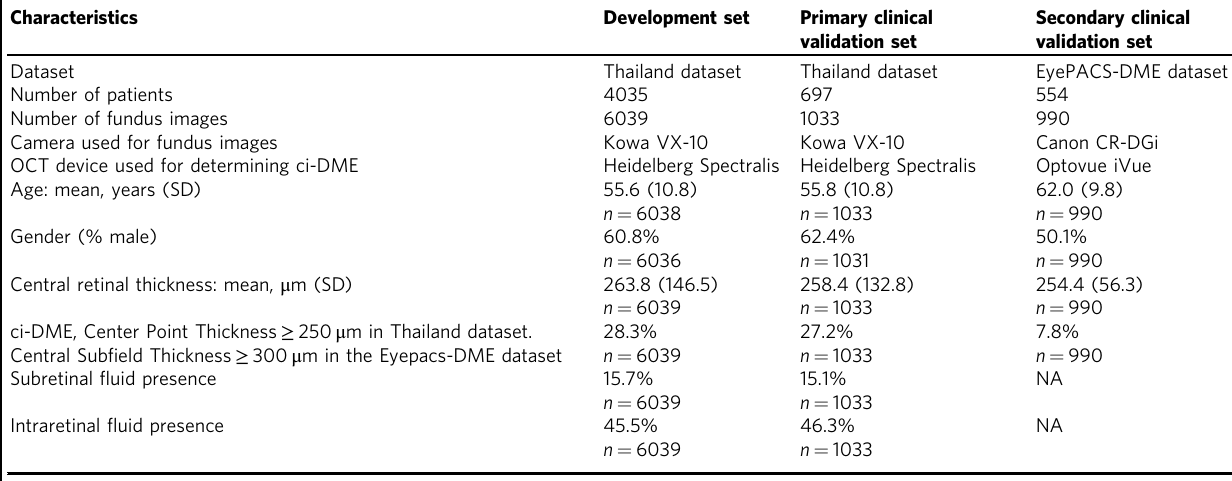
Table 1 Baseline characteristics of the development and clinical validation datasets.